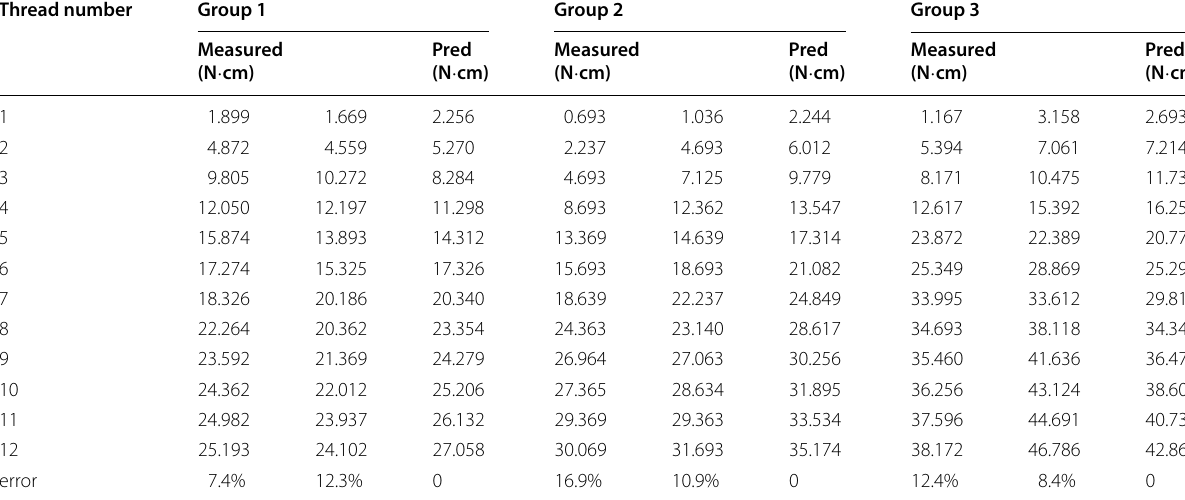
Table 6 Comparison of averaged insertion torques from experiments and predictions Thread